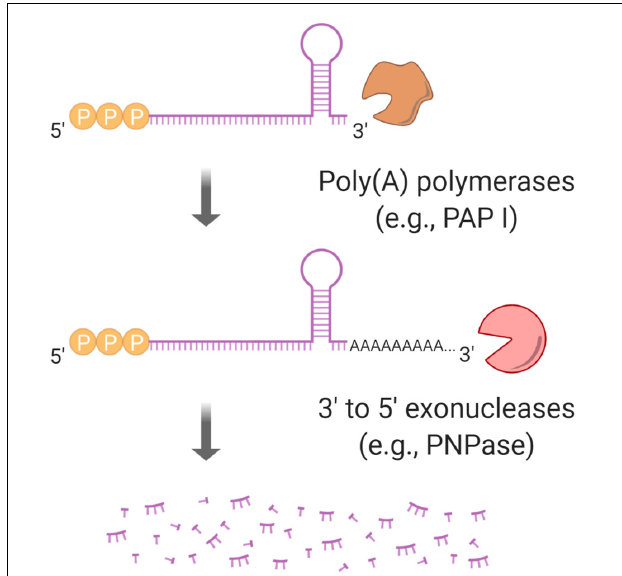
FIGURE 6 | Polyadenylation regulates mRNA half-life. Stem-loops at mRNA 3 (cid:48) ends block 3 (cid:48) –5 (cid:48) exoribonucleases such as PNPase. PAP I, a poly(A) polymerase, can facilitate an exoribonuclease “grip” by synthesizing a poly(A)